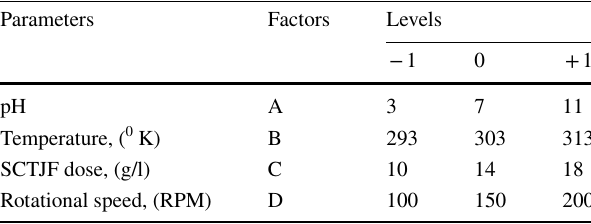
Table 4 Cost comparison of SCTJF with activated carbon